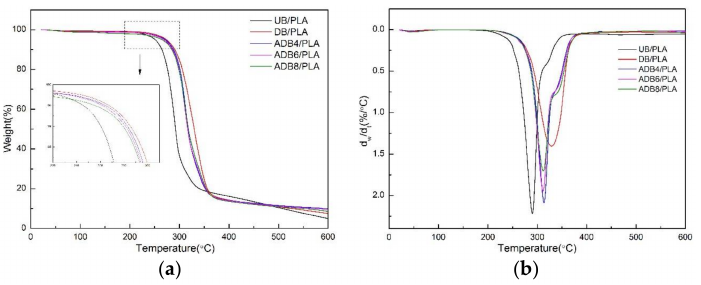
Figure 3. Thermogravimetric analysis (TGA) curves ( a ) and DTG curves ( b ) of various treatments of the effect on thermal properties of BF/PLA